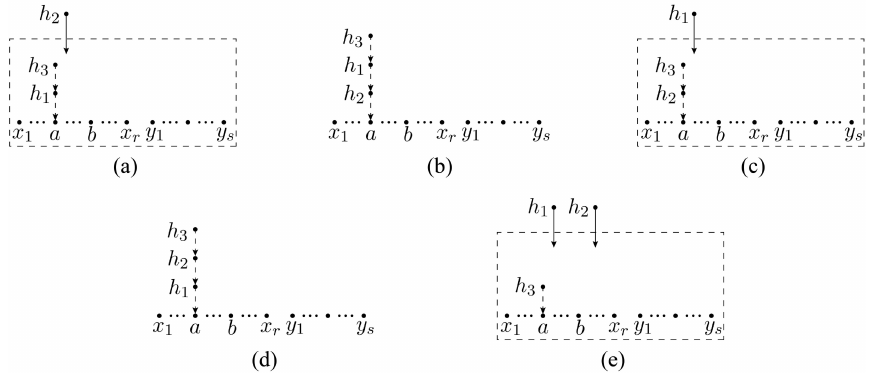
Figure 14 . All three-graviton graphs with h 3 as starting node of a chain pointing towards gluon a via one or several type-4